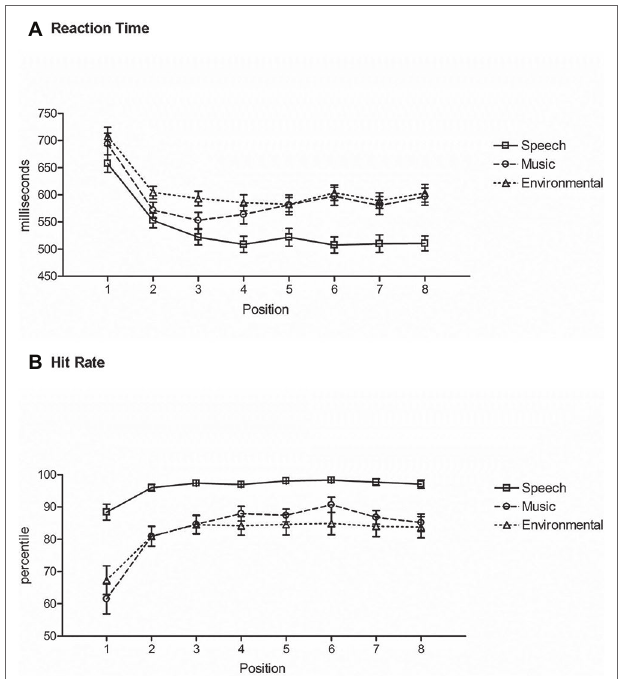
FIGURE 4 | Repetition-Switch condition. (A) Reaction time: mean RT (in milliseconds, y -axis) at each position ( x -axis) for responses to speech (square, solid line), music (circle, dashed line), and environmental (triangle, dotted line) sounds. Position 1 is a category switch and Position 5 is a category repeat. (B) Hit rate: mean HR ( y -axis) at each position ( x -axis) for responses to speech (square, solid line), music (circle, dashed line), and environmental (triangle, dotted line) sounds. Position 1 is a category switch and Position 5 is a category repeat. Whiskers show the standard